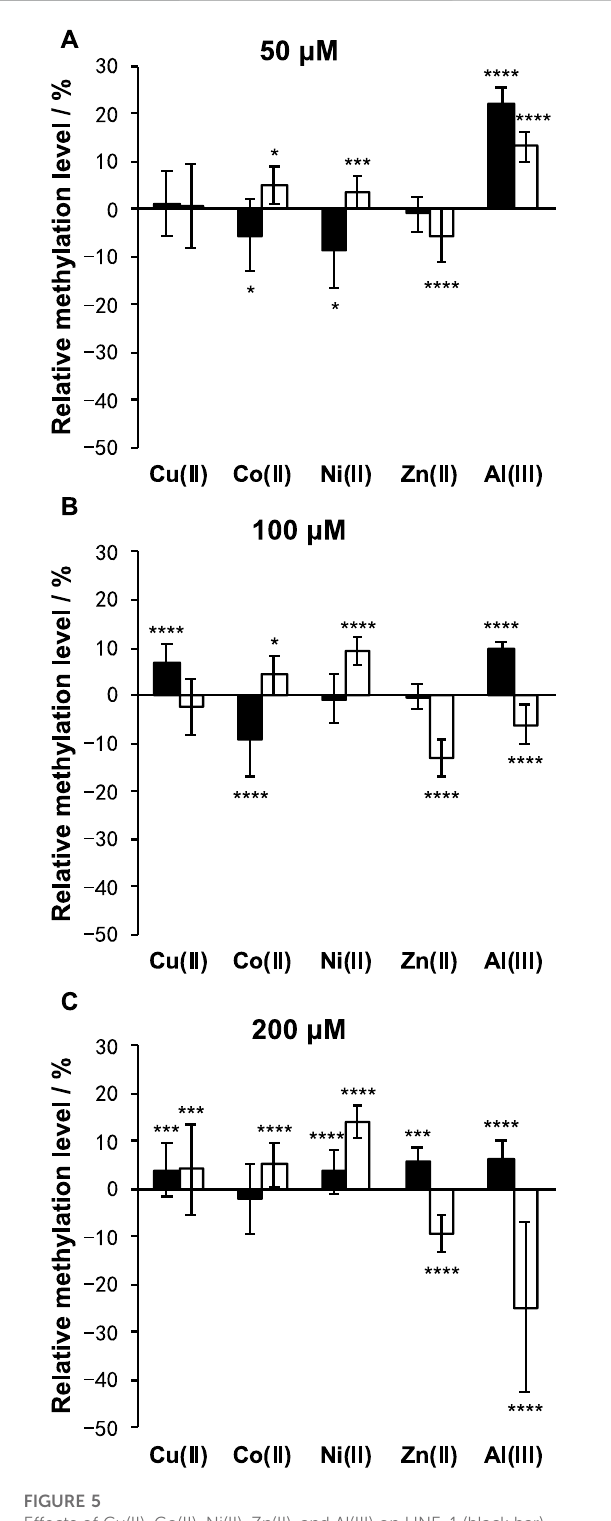
FIGURE 5 Effects of Cu(II), Co(II), Ni(II), Zn(II), and Al(III) on LINE-1 (black bar) and α -sat (white bar) methylation, at (A) 50 μ M, (B) 100 μ M, and (C) 200 μ M. The differences between the treated and untreated group assays were evaluated after 1 day of exposure. The error bars represent standard errors. * p < .05, *** p < .005, and **** p < .001